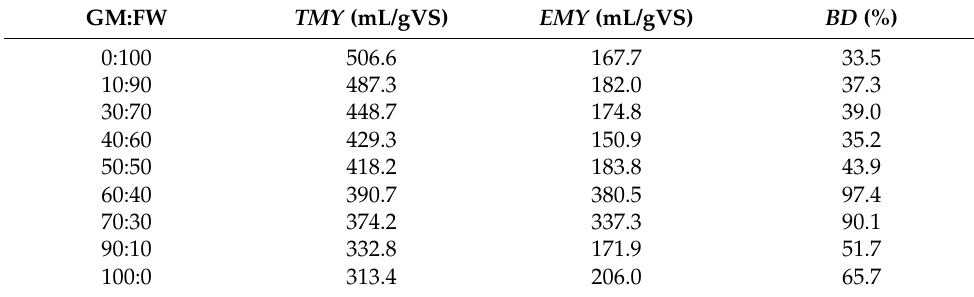
Table 4. Biodegradability ( BD ) of GM and FW mono and co-digestions.